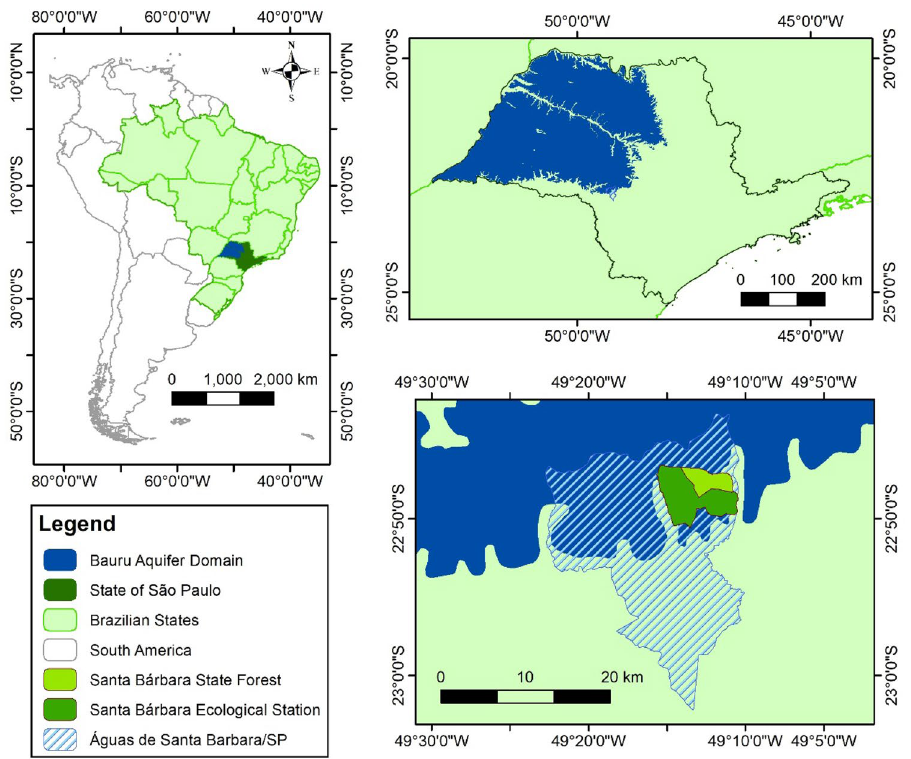
Fig. 3 Location of study area with the main ecological and hydrogeological